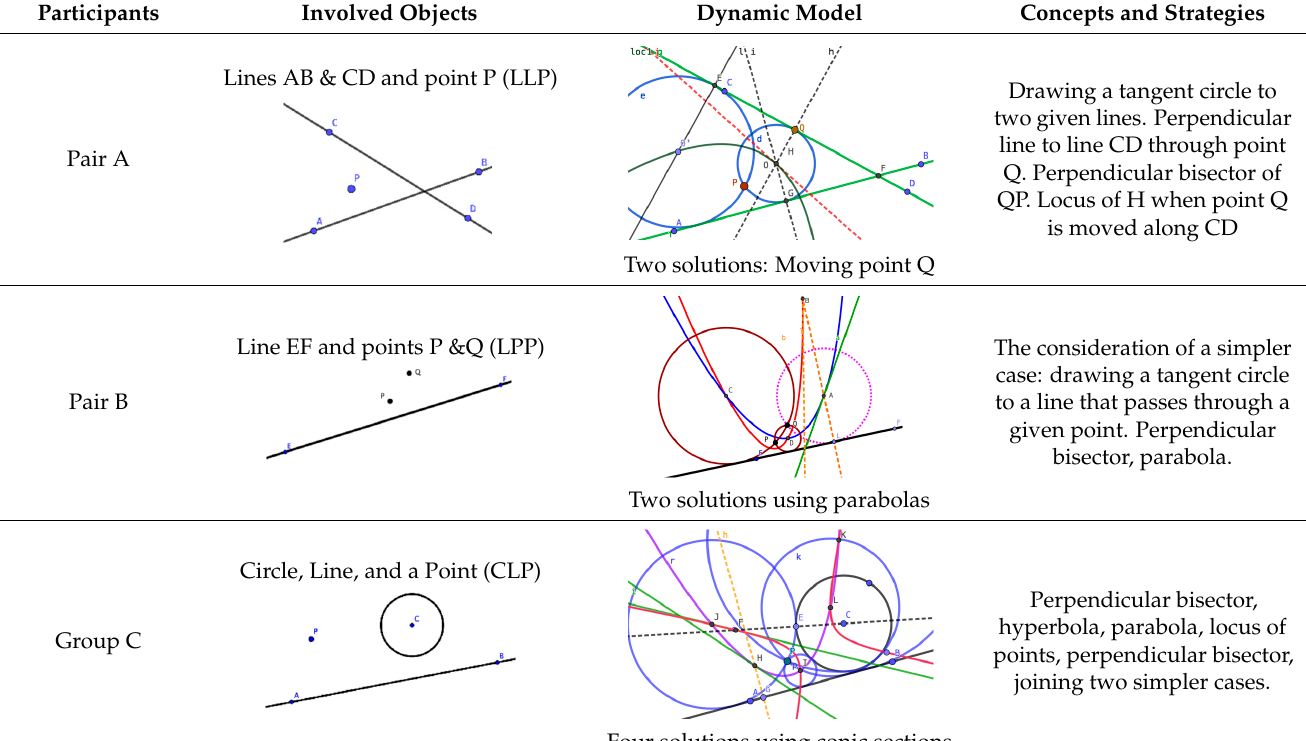
Four solutions using conic sections